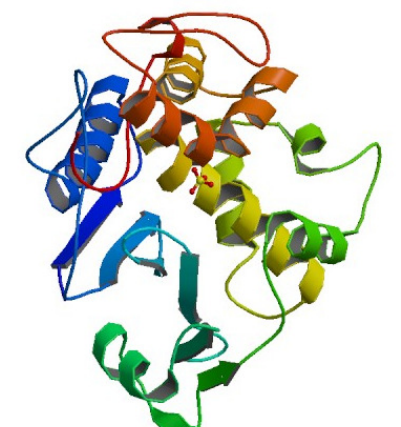
Figure1. Crystal structure of saporin SO6 (https://doi.org/10.2210/pdb1QI7/pdb) (Source: RCSB